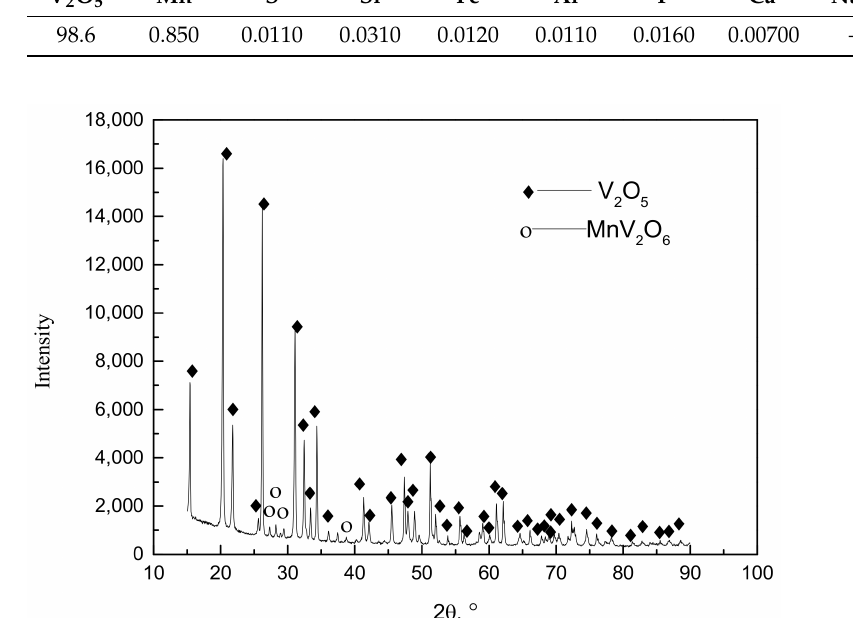
Figure 19. X-ray diffraction pattern of the vanadium pentoxide